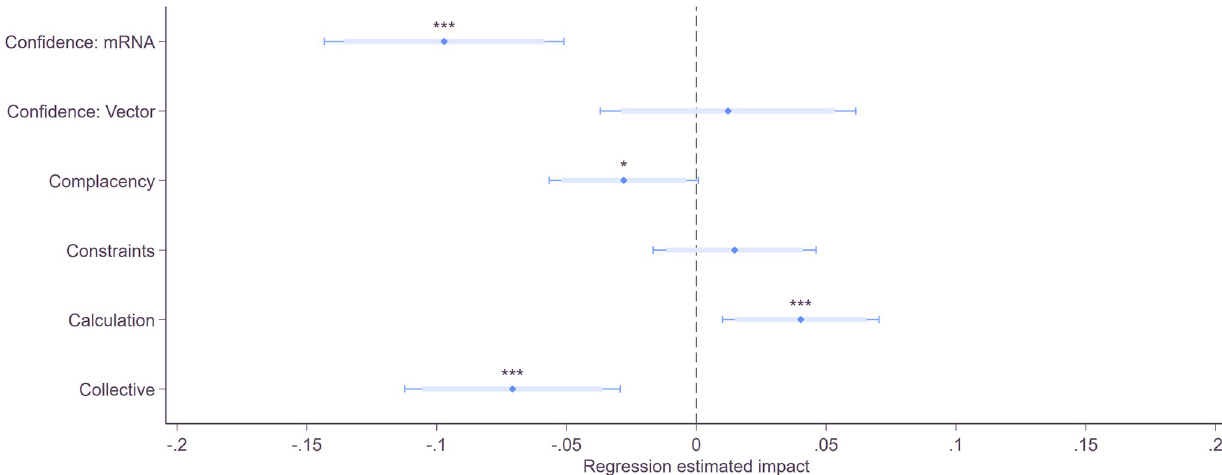
Fig 5. Vaccination inaction and 5Cs. Regression estimates for the five psychological antecedents of vaccination with the binary variable inaction in the second wave as the dependent variable from linear probability models are presented. We also control for gender, age, education, adjusted household income, marital status, denied other vaccines, COVID-19 risk perception, negative emotions, net anticipated regret, and dogmatism. Estimates are obtained from multiple least square regressions with robust standard errors: ��� p < .01, �� p < .05, � p < .1. Full regression outputs are reported in S9 Appendix.